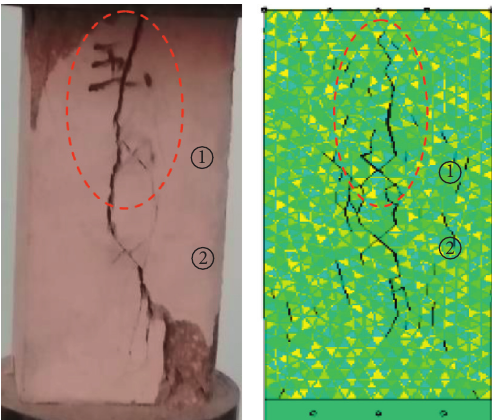
Figure 8: Comparison of test and discontinuous deformation simulation of rock-like specimen made with double “X” fractures.